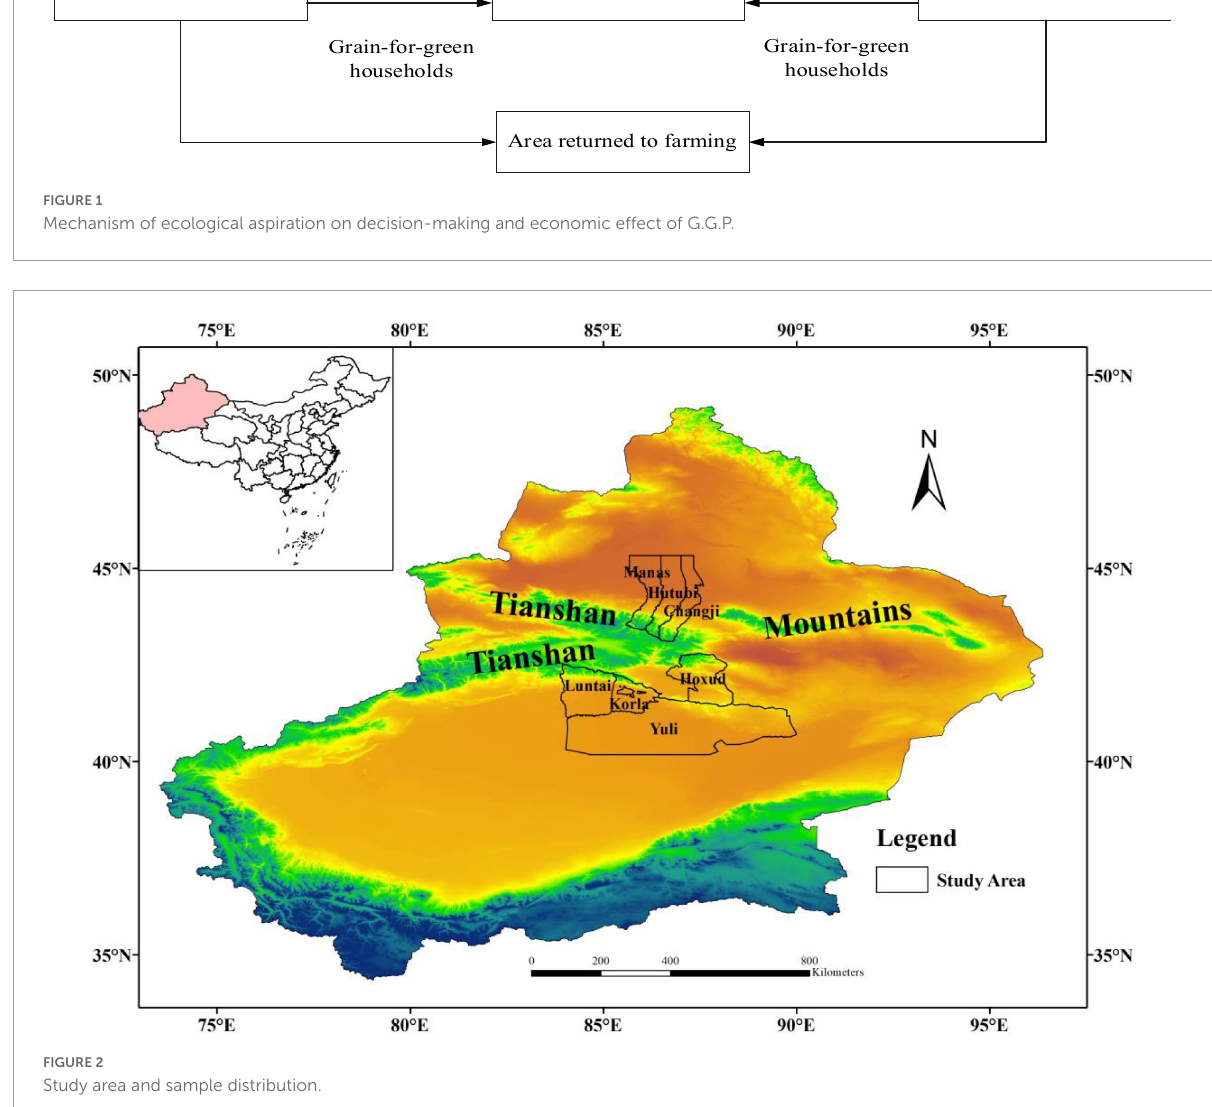
FIGURE2 Study area and sample